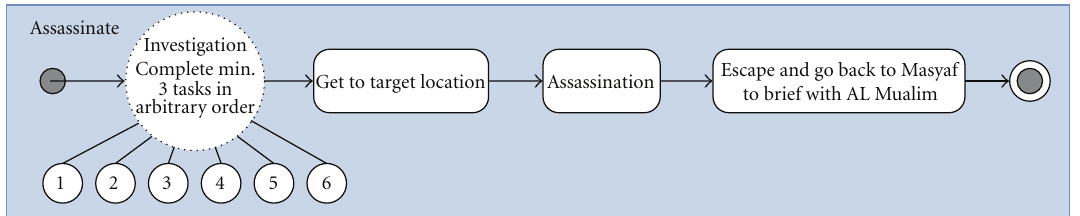
Figure 9: A plot unit in Assassin’s Creed